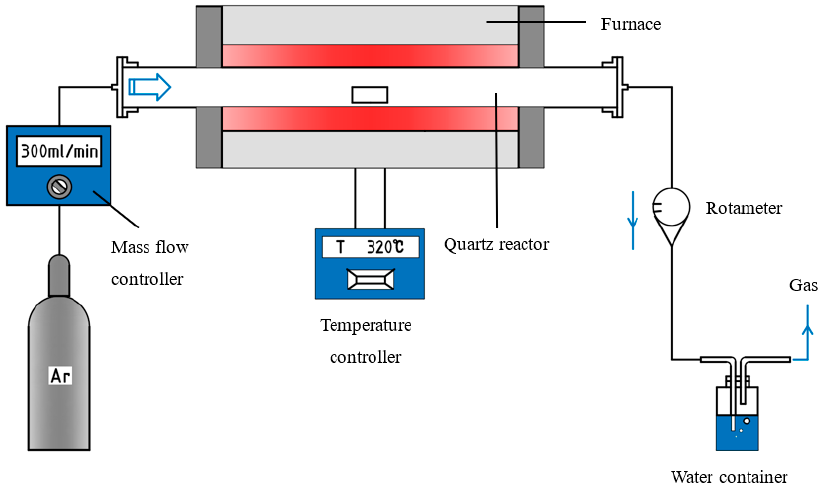
Figure 1. Diagram of co-pyrolysis experimental equipment.